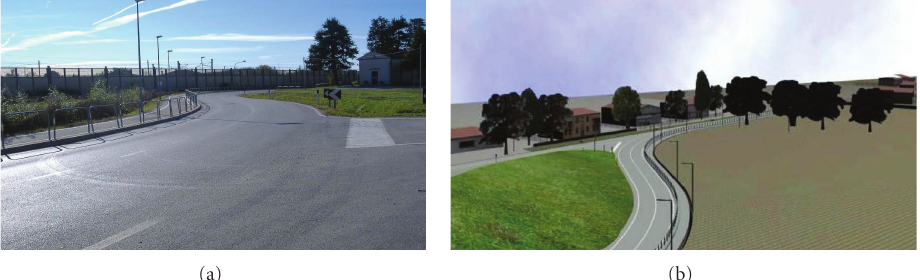
Figure 5: Real environment (westbound picture) and virtual environment (eastbound drawing): representation of the S-shape curve and the intersection.